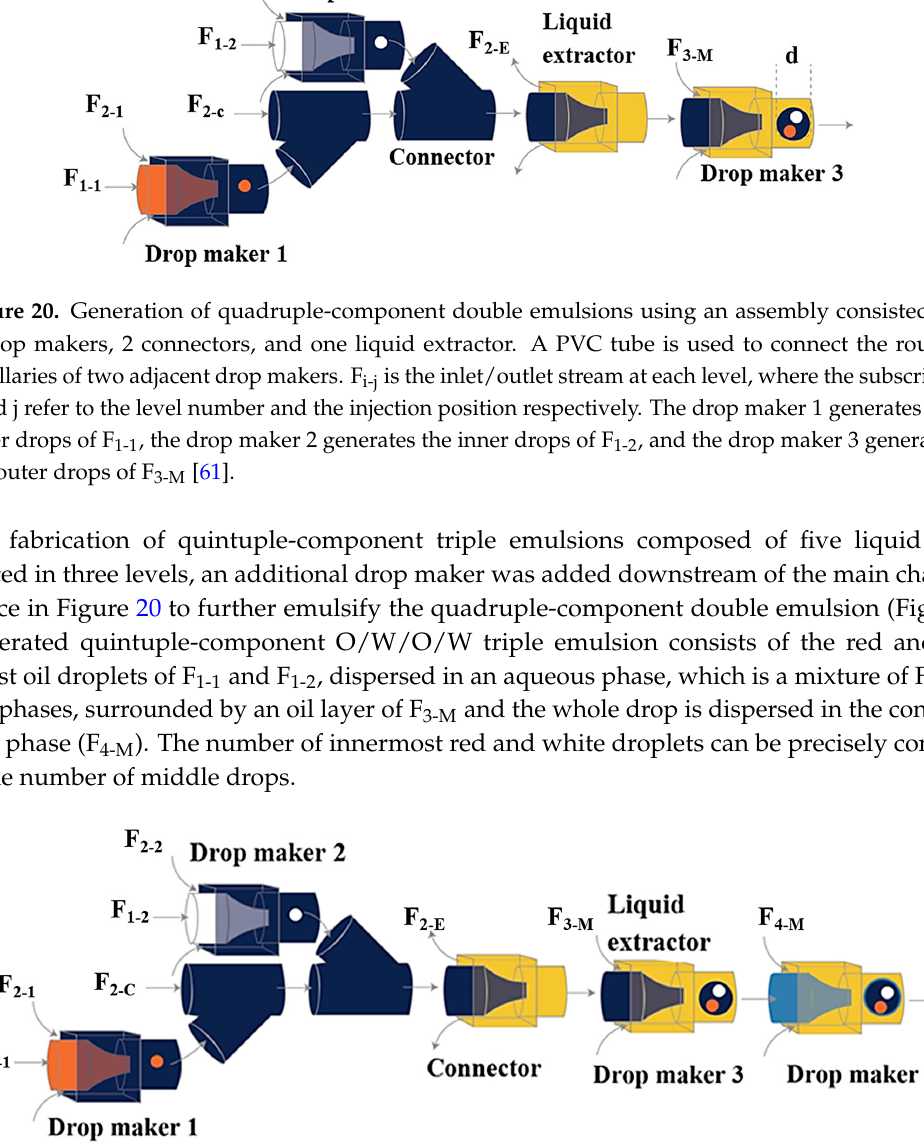
Figure 21. Generation of quintuple-component triple emulsions using an assembly consisted of 4 drop makers (two makers are used for the inner drops, one for the middle drops and one for the outer drops), 2 connectors, and 1 liquid extractor [61].